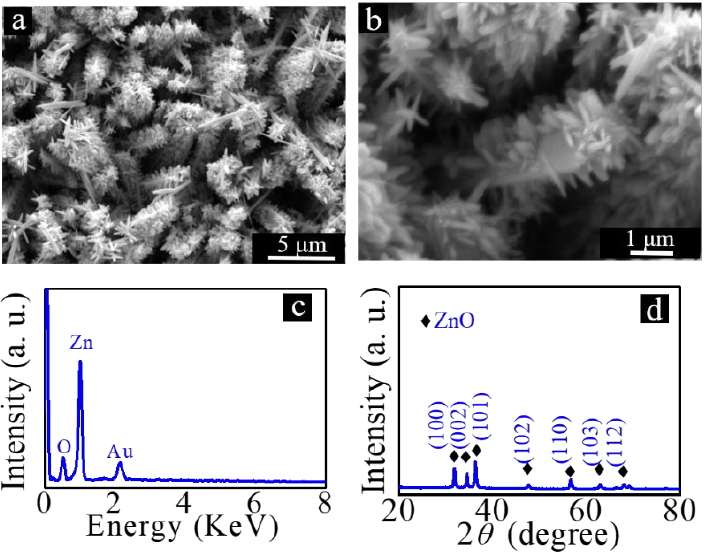
Figure 5. ( a ) Low- and ( b ) high-magnification SEM images of hierarchical ZnO micro/nanostructures; ( c ) EDX spectrum and ( d ) XRD diffraction patterns of hierarchical ZnO micro/nanostructures.